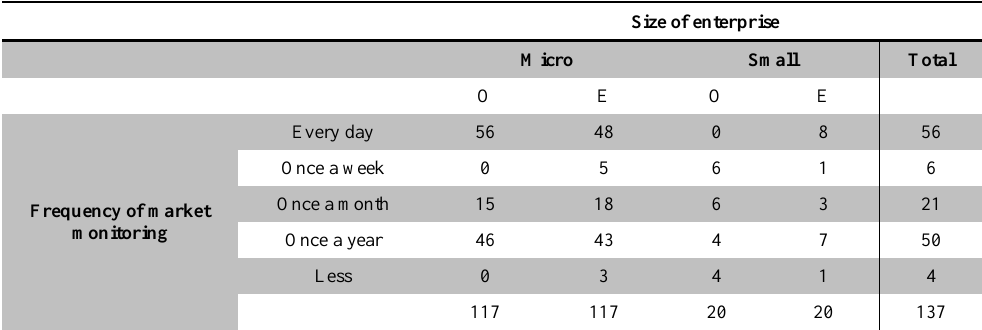
Table 3. Results of expected value